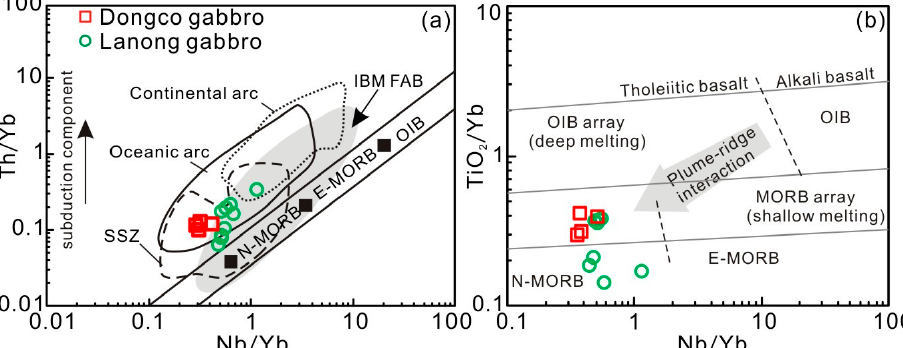
Figure 10. Tectonic discrimination diagrams for the investigated non-cumulative gabbros from the Dongco and Lanong ophiolites. ( a ) Plots of Nb/Yb–Th/Yb [59]. Supra-subduction-zone types are from references [1,60–62]. ( b ) Plots of Nb/Yb–TiO 2 /Yb [59]. Abbreviations: IBM—Izu Bonin Mariana, FAB—Fore arc basalt, MORB—Mid-ocean ridge basalt, OIB—Ocean island basalt.